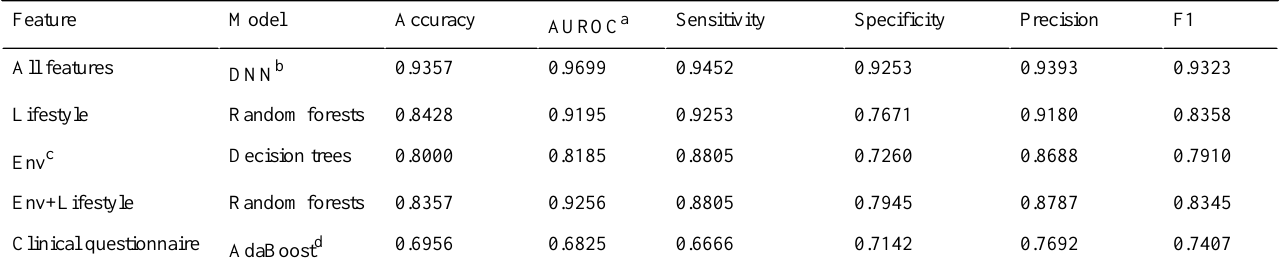
Table 4. Performance given different feature sets.